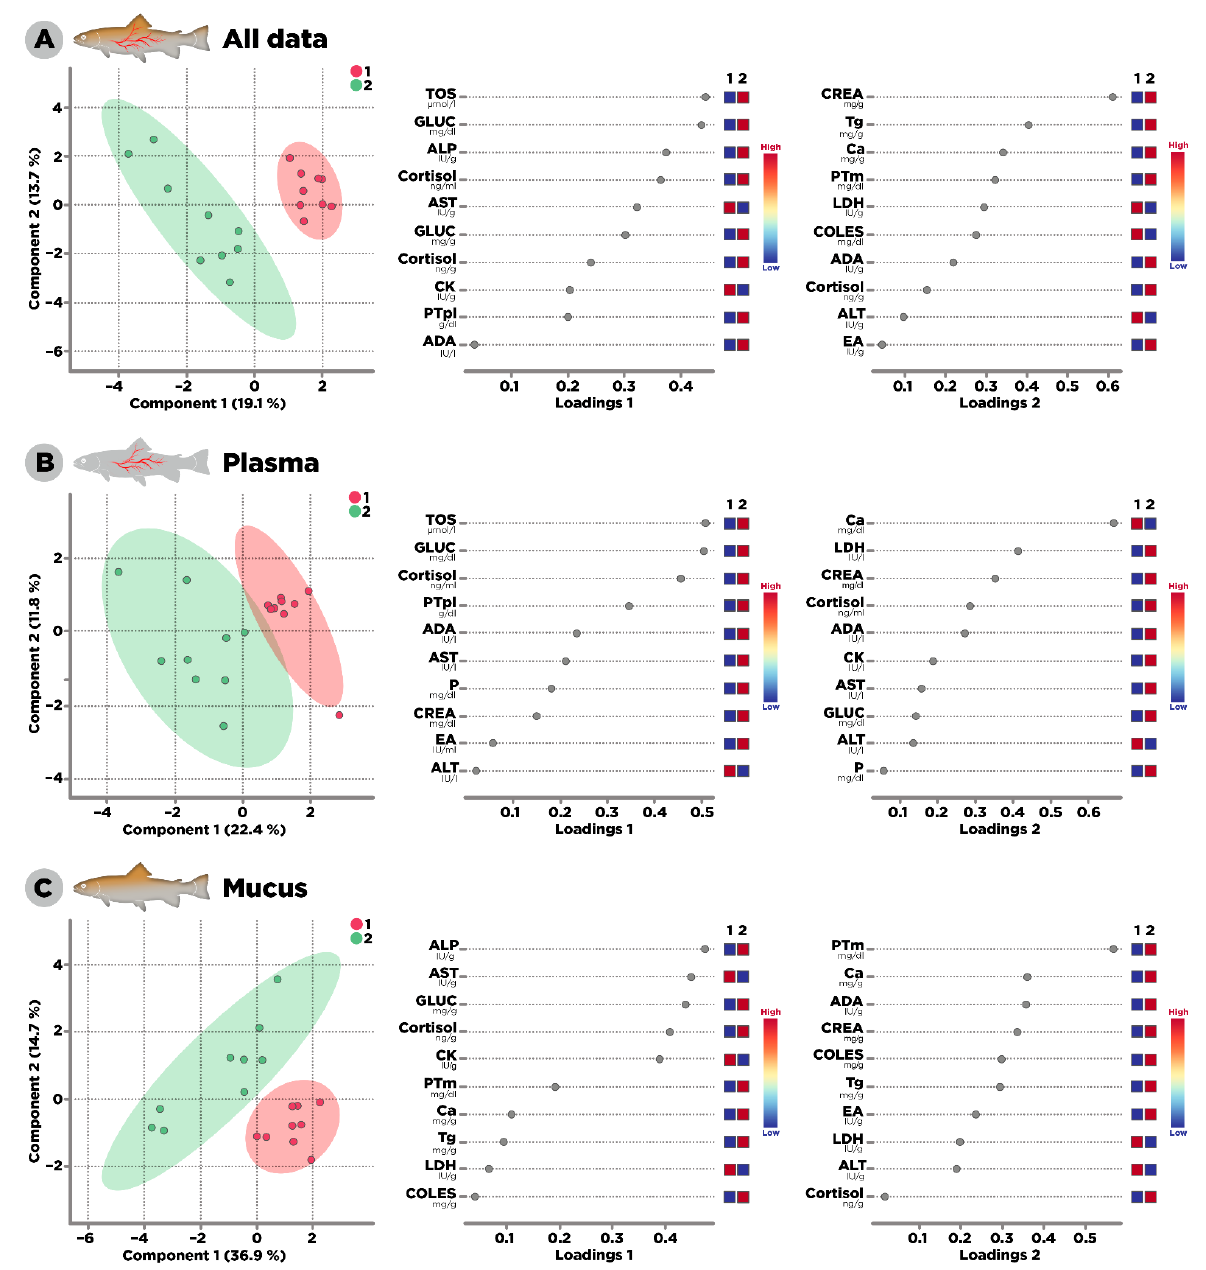
Figure 2. Sparce principal component analysis (sPCA) based on the biochemical parameters analysed. ( A ) sPCA analysis including all data. ( B ) sPCA analysis for data obtained from plasma. ( C ) sPCA for data obtained from mucus. The graphs on the left column represent Variable Importance in Projection (VIP) in two loadings (loading 1 is for component 1; loading 2 is for component 2) with 10 variables per component and 5-fold CV validation. Green area: control animals; and red area: stressed animals. For the graphs represented on the central and right column, the blue square represents low values, meanwhile the red square denotes high values, as indicated on the grade scale colour on the right of each graph. The array of parameters measured in plasma and skin mucus were as follows: glucose (GLUC), alkaline phosphatase (ALP), aspartate transaminase (AST), alanine aminotransferase (ALT), lactate dehydrogenase (LDH), creatinine kinase (CK), creatinine (CREA), calcium (CA), phosphorus (P), proteins plasma (PTpl), proteins plasma (PTm), cholesterol (COLES), triglycerides (Tg), esterase activity (EA), total oxidative status (TOS), and adenosine deaminase